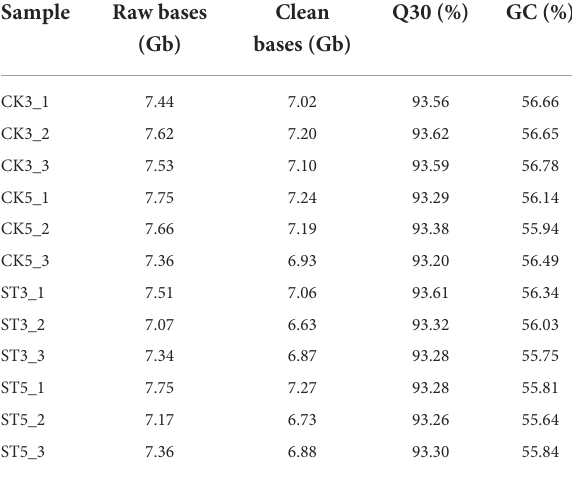
TABLE 1 Summary of RNA-seq data from rice shoots grown under control conditions (CK) and salt treatment (ST) at two time periods, with three biological replicates for each